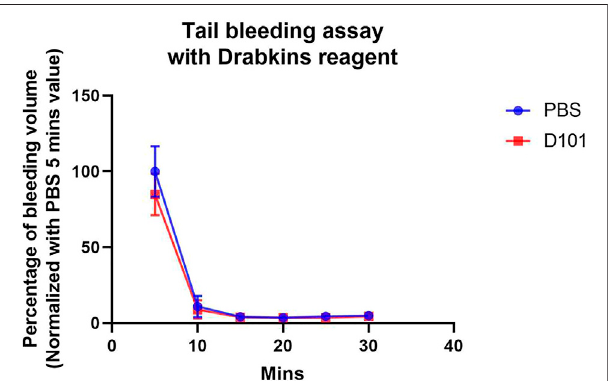
FIGURE 9 | No signi fi cant effect on coagulation was observed in C57BL6/N mice treated with the D101 fraction. C57BL6/N mice were treated with either PBS or D101 fraction for 14 consecutive days and the bleeding pattern was accessed. No signi fi cant anti-coagulating pattern was observed in mice with D101 fraction treatment. Data are presented as the mean and SEM ( n = 3). Values were analyzed by unpaired t test in each time interval.